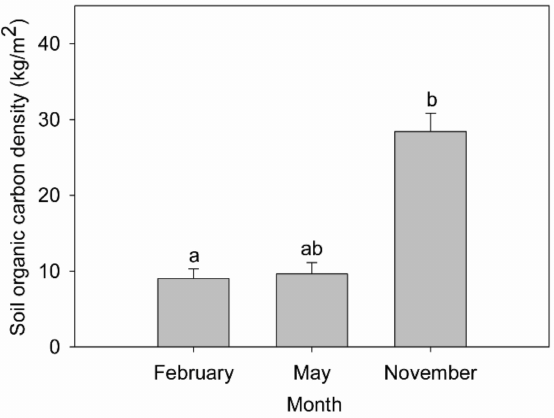
Figure 3. Seasonal variation of soil organic carbon in the lakeside of West Mauri Lake.